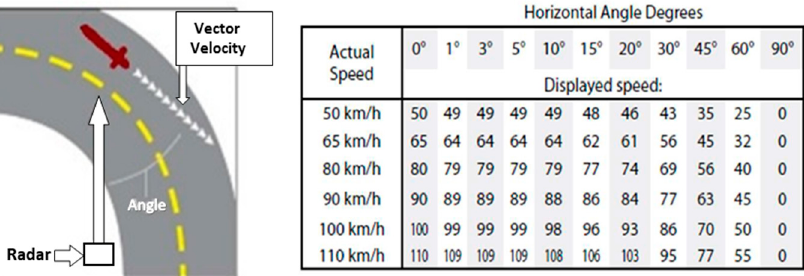
Figure 2. Relationship between antenna target angles and speed.